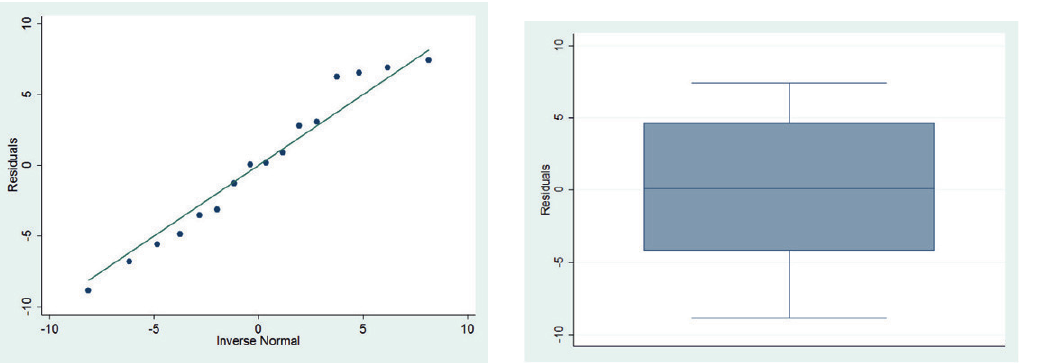
Fig. 2. Residual box-plot for detection of outliers. Fig. 1. Normality assessment of the error term